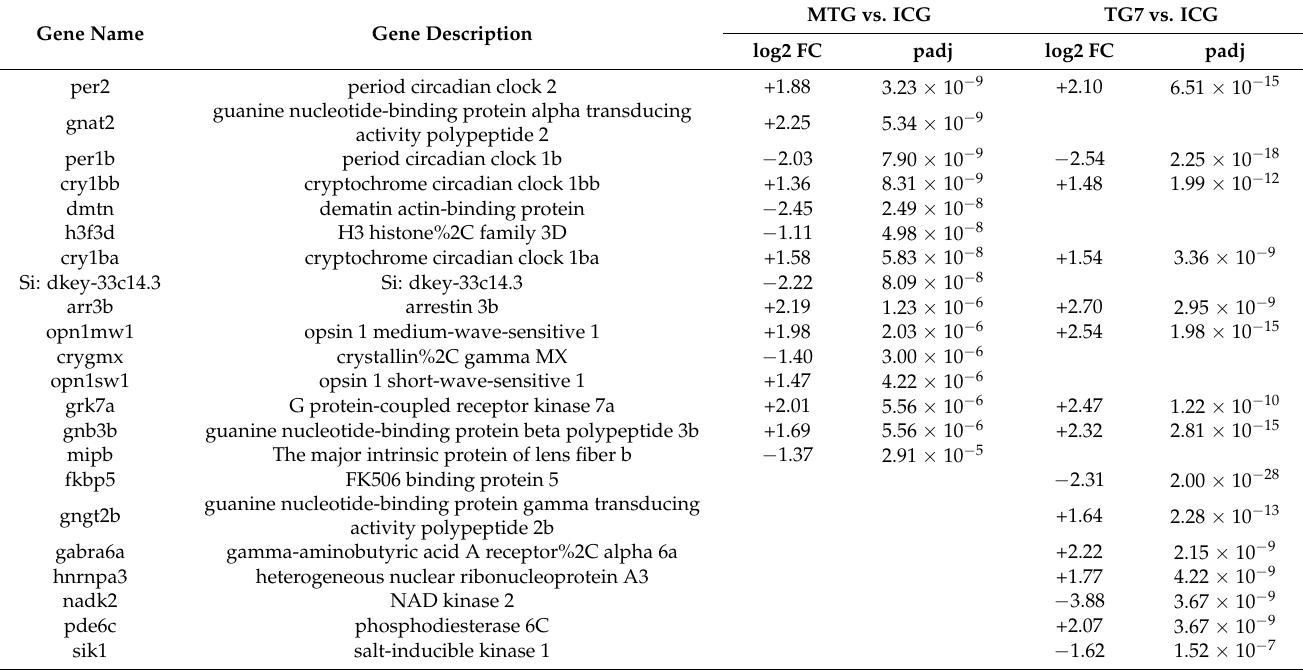
Table 1. Expression result comparison of 15 genes between MTG and TG7 with ICG. Insomnia control group (ICG); Positive drug (melatonin) group (MTG); Tyr-Gly-Asn-Pro-Trp-Glu-Lys